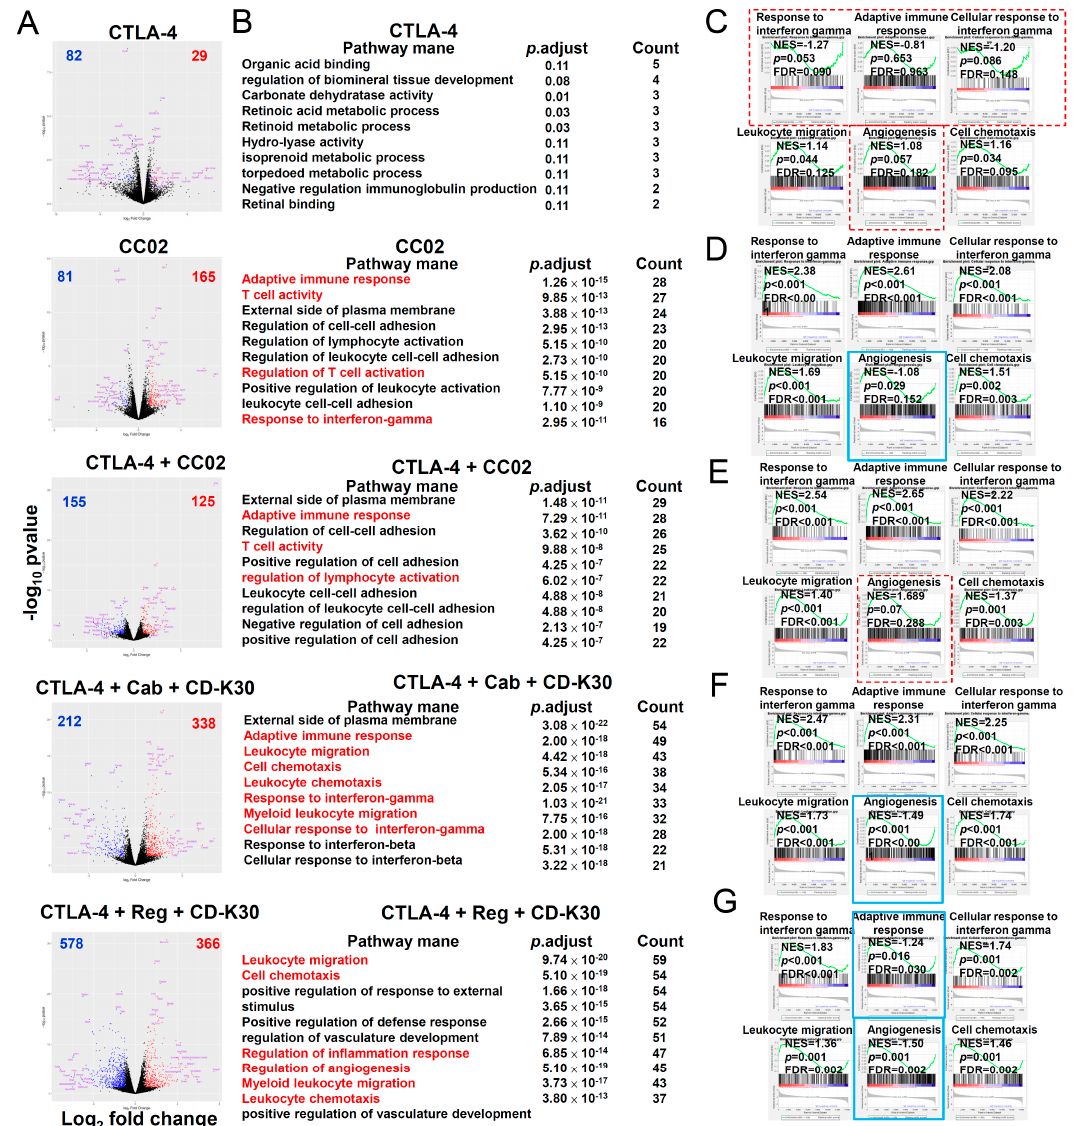
NK and T-cell gene expressions, while also reflecting a similar antitumor activity as shown in Figure 5G. In addition, treatment with anti-CTLA-4 antibody + cabozantinib + chidamide-k30 significantly activated NK and T-cells, and monocytes, as well as macrophage and neutrophil gene expressions, while treatment with anti-CTLA4 antibody + regorafenib + chidamide-k30 activated neutrophil gene expression and significantly suppressed macrophage, monocyte, and T-cell gene expressions, while both regimens reflected a similar antitumor activity, as shown in Figure 5G. In the TME, the antitumor mechanisms underlying these two triple combination regimens may be different and further elucidation in future study is necessary.